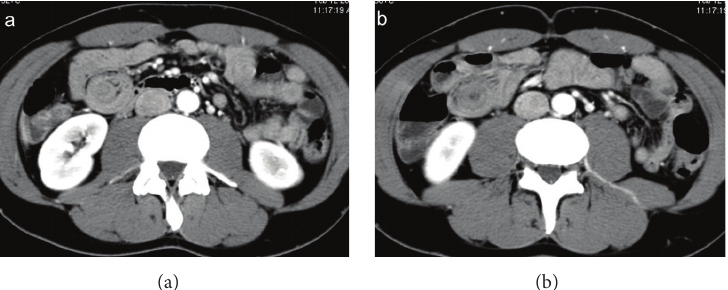
Figure 8: Enteroenteric (ileoileal) intussusception. Target-like mass on axial CT images. Transient intussusception with no signs of intestinal obstruction or intestinal